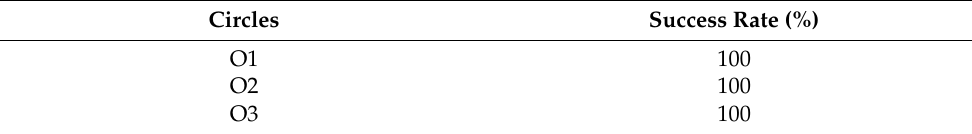
Table 2. The success rate of the algorithm with different coaxial circles.